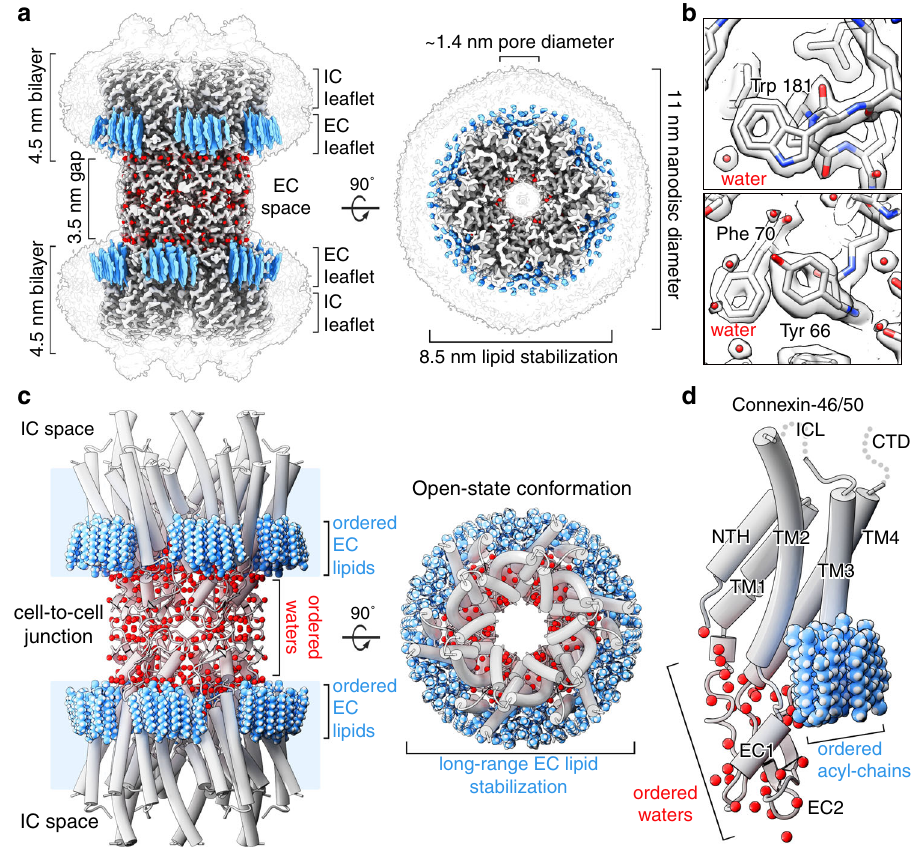
Fig. 1 Structure of connexin-46/50 in lipid nanodiscs by CryoEM. a CryoEM 3D reconstruction of Cx46/50 (white) in an open-state conformation, with resolved lipid acyl chains (blue) and water molecules (red). Transparent silhouette displays the map at low contour to illustrate the dimensions of the lipid nanodisc densities, with intracellular (IC) and extracellular (EC) lipid lea fl ets indicated. b Zoom views of the CryoEM map and fi tted atomic models, showing high-resolution features observed at 1.9 Å resolution. c Model of Cx46/50 (cylinder representation) with extracellular (EC) lipids and ordered water molecules displayed (spheres). d Cx46/50 monomer, 15 bound lipids, and 33 waters associated with each subunit. Domains labeled for transmembrane helices (TM1 – 4), extracellular loops (EC1 – 2), and N-terminal helix (NTH). The intracellular loop (ICL) and C-terminal domain (CTD) are not resolved, indicated by dotted